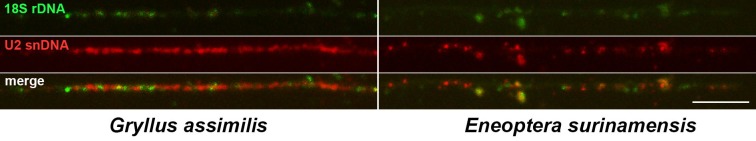
Fiber-FISH of the 18S rDNA and U2 snDNA probes in G. assimilis (a) and E. surinamensis (b).Note that these probes are co-localized and are interspersed in both species.